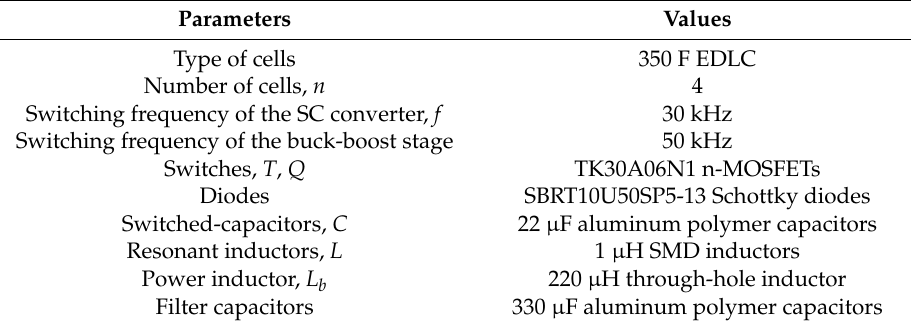
Table 2. Key parameters of the experimental setup.